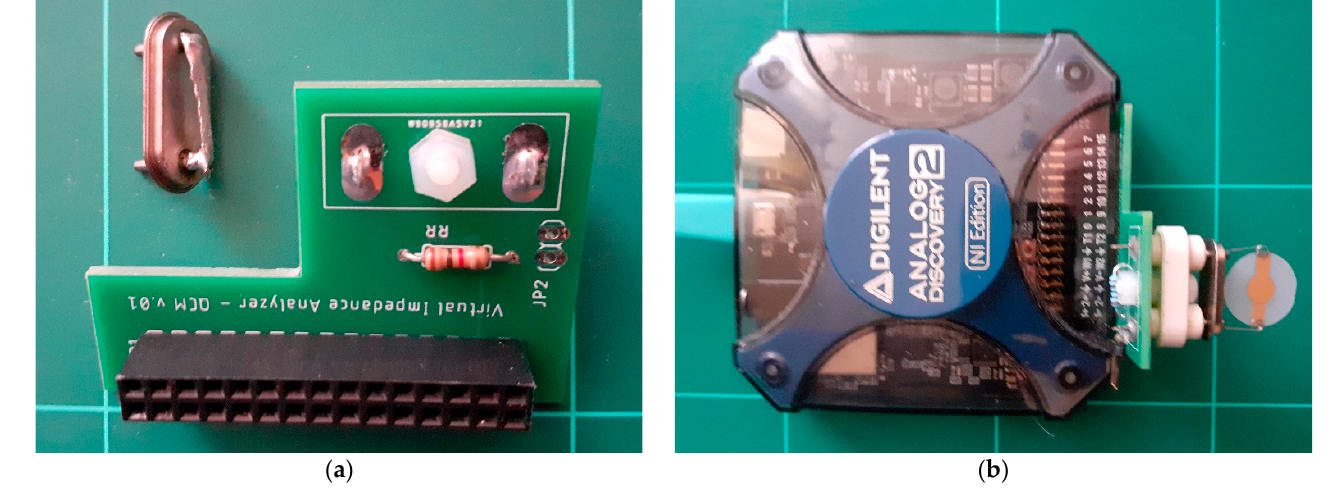
Figure 2. The virtual QCM: ( a ) half-bridge circuit in shunt configuration and the support device for short circuit compensation, ( b ) experimental setup of the virtual QCM.